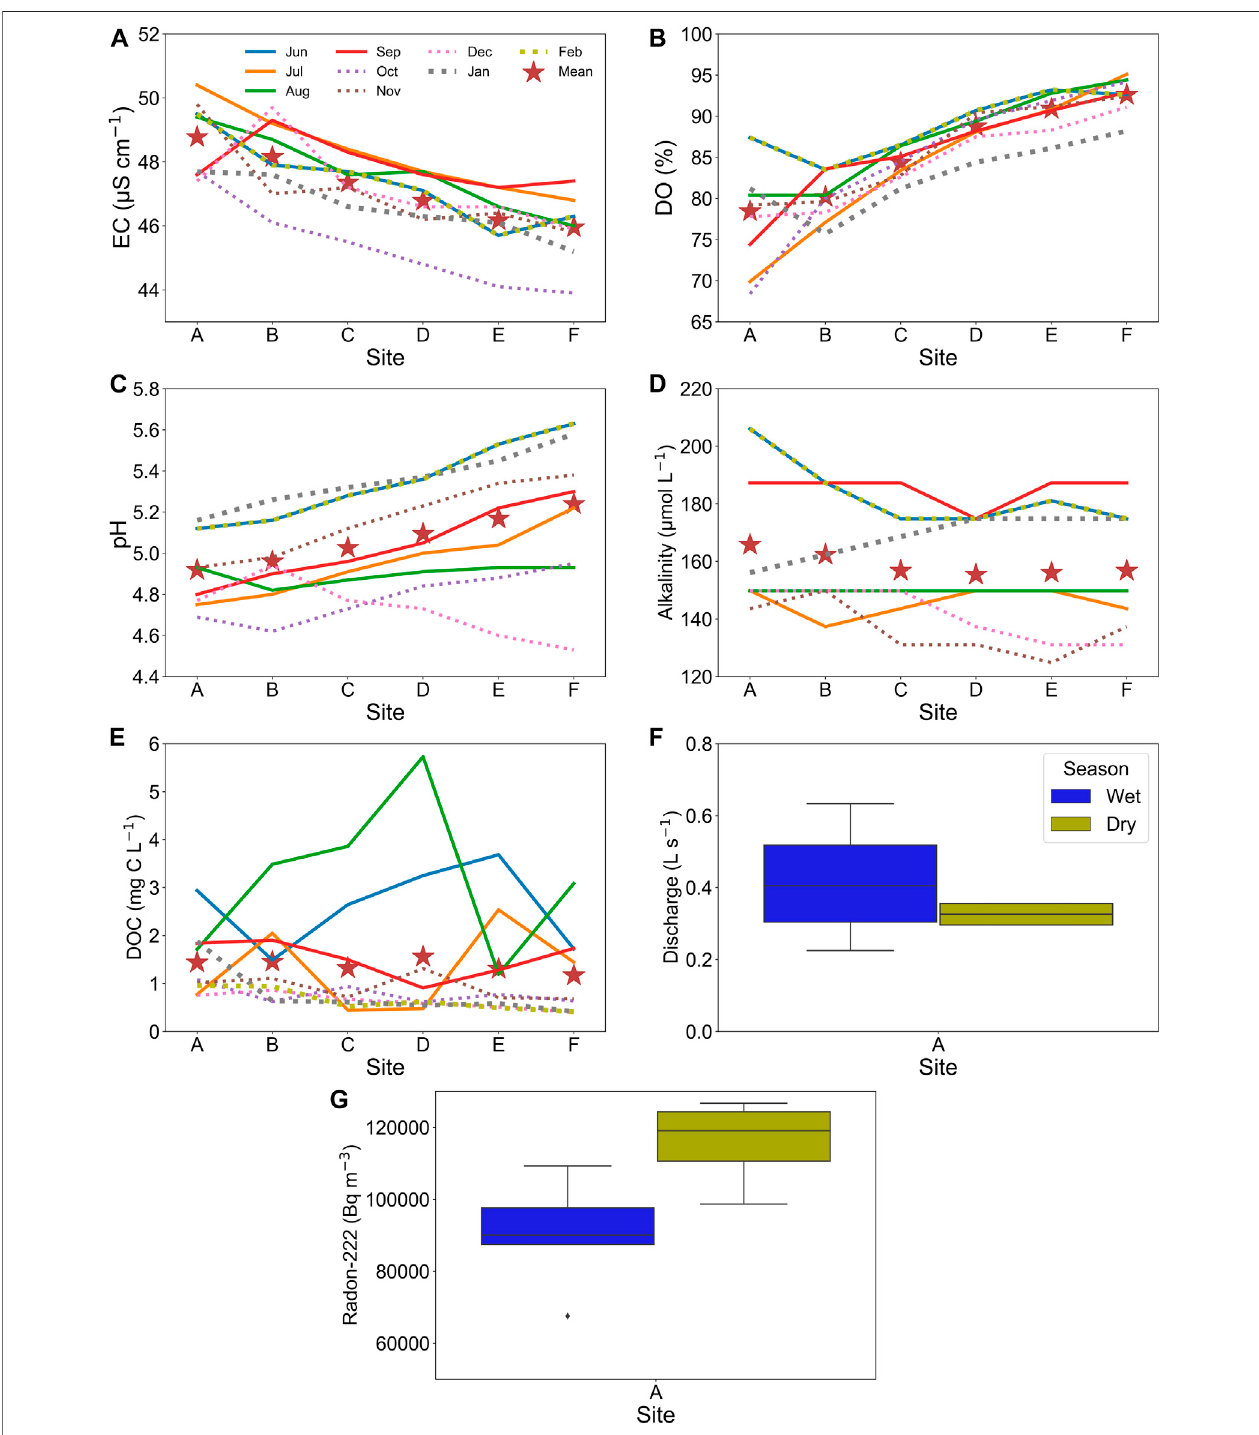
FIGURE2| Plotssummarizingthemonthlywaterqualityvariables,includingEC (A) ,DO (B) ,pH (C) ,alkalinity (D) ,andDOC (E) ofsitesA — F,anddischarge (F) and radon-222 (G) of site A between wet and dry seasons in the headwater stream.